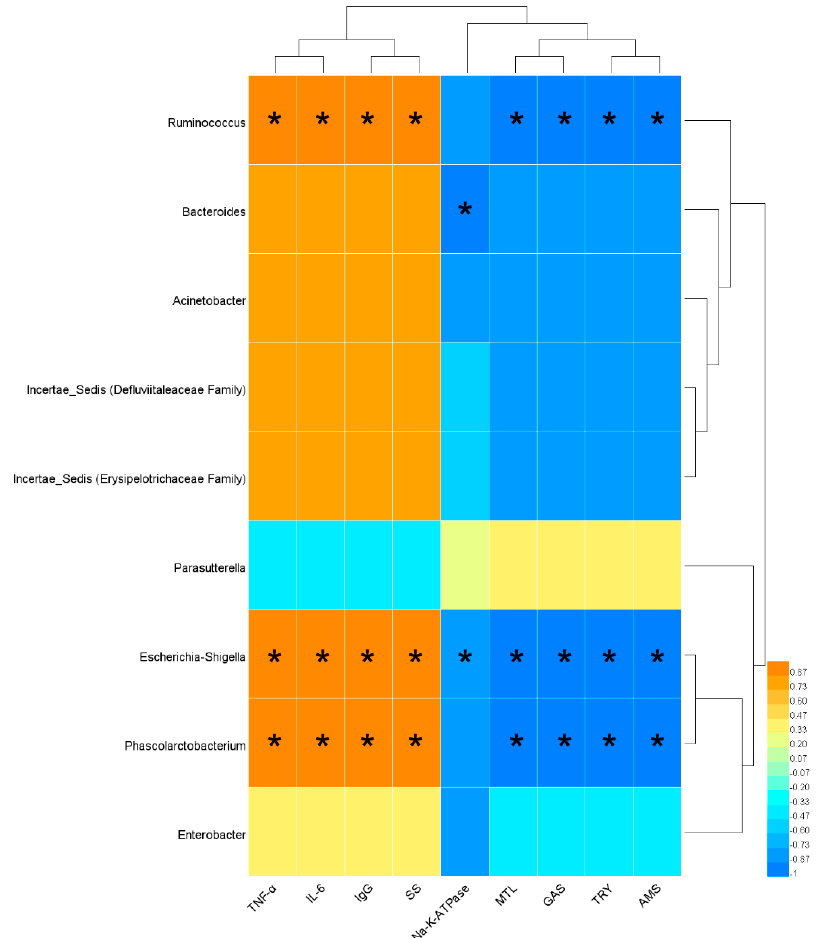
Figure 6. Heatmap of correlation coefficients between serum biochemical indices and bacterial abundance indices closely related to SDS. The x-axis indicates the serum biochemical indices and the y-axis indicates the bacteria closely related to SDS. Yellow represents positive correlation, while blue represents negative correlation. ‘*’ indicates a significant correlation ( P < 0.01).